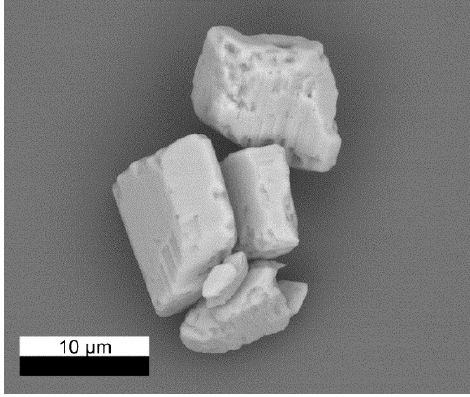
Figure 1. Scanning electron microscopy (SEM) image of initial barite particles before recrystallization experiments.